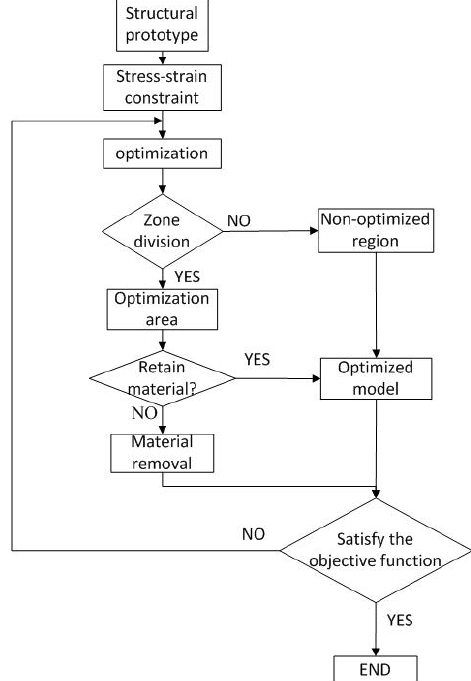
Figure 5. Topology optimization flowchart.